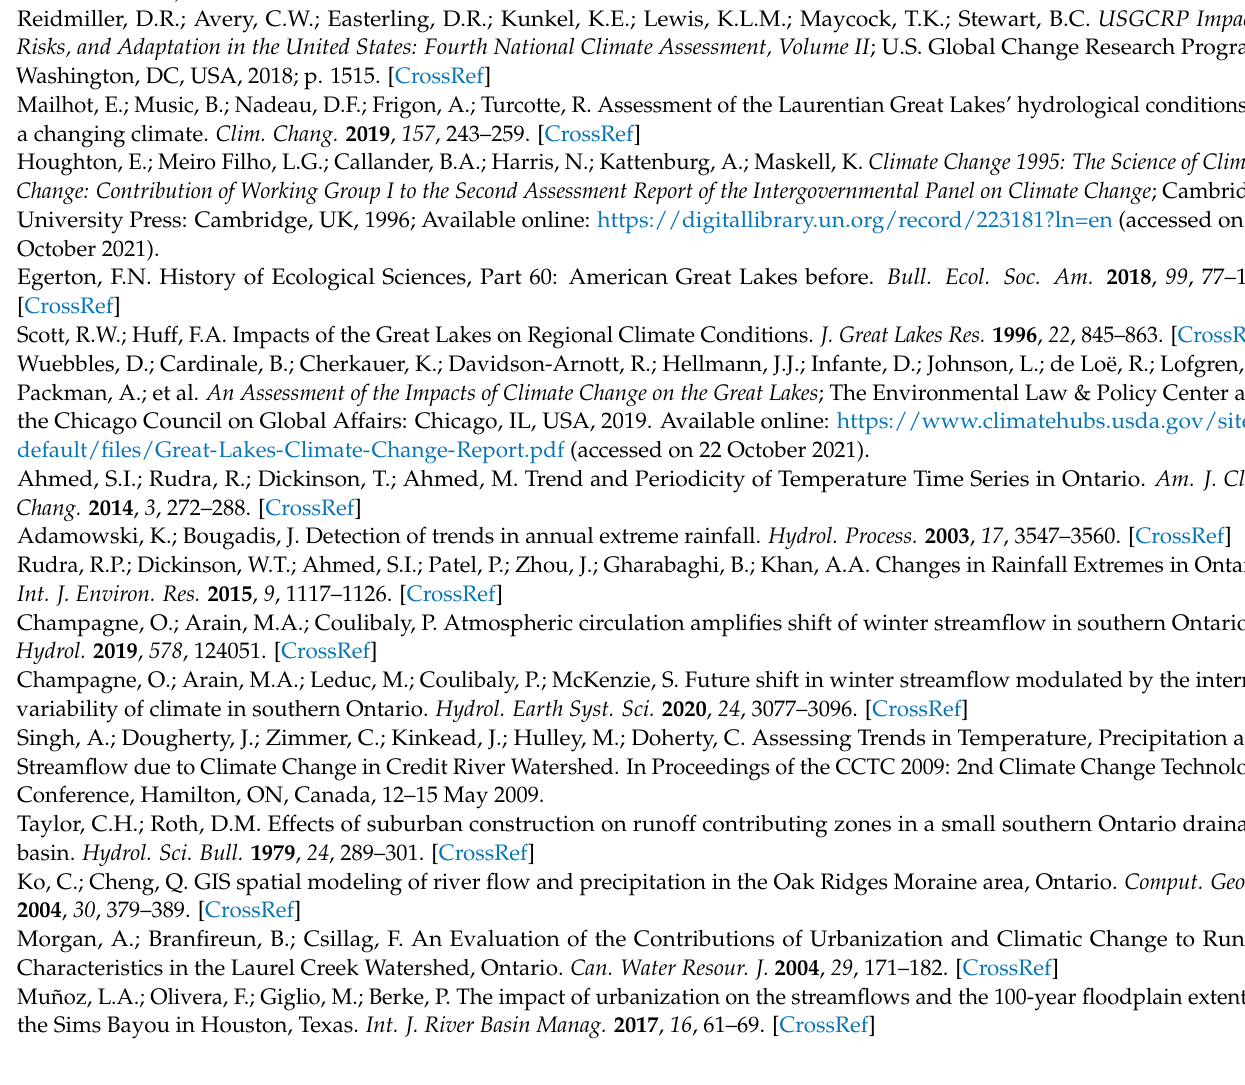
Table S7: Summary of the trend analysis for the period 1971–2019, Table S8: Summary of the trend analysis for the period